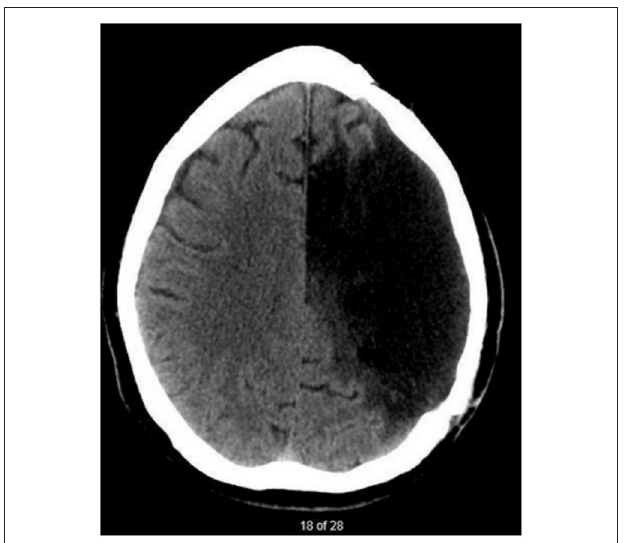
FIGURE 1 | CT scan taken 3 years after JB’s stroke. There is evidence of a large, chronic post-stroke lesion within the left-hemisphere. Regions affected are associated with branches of the left middle cerebral artery.